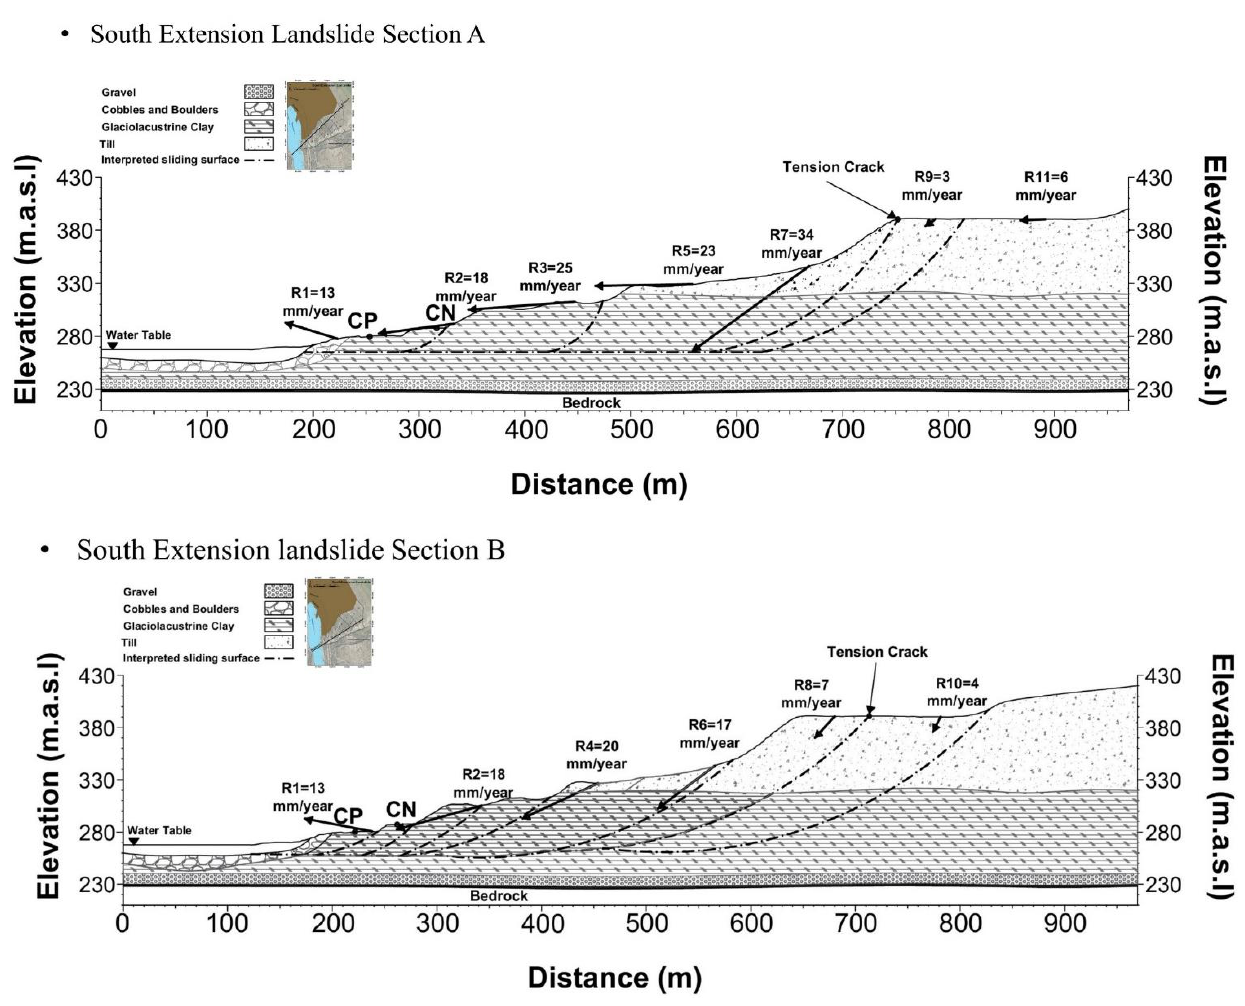
Figure 19. Calculated vertical component of R for selected sectors on the South Extension landslide.